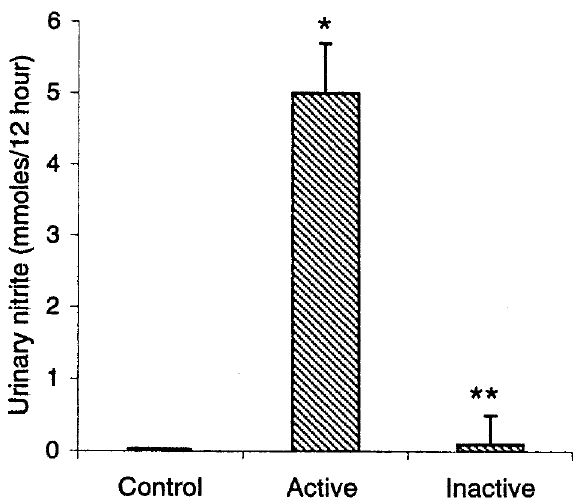
FIG. 1. Timed 12-h urinary nitrite was assayed in patients with active and inactive inflammatory bowel disease (as defined by the Harvey–Bradshaw index ( n = 32 and n = 14, respectively)). * P < 0.05 versus control, ** P < 0.05 versus active